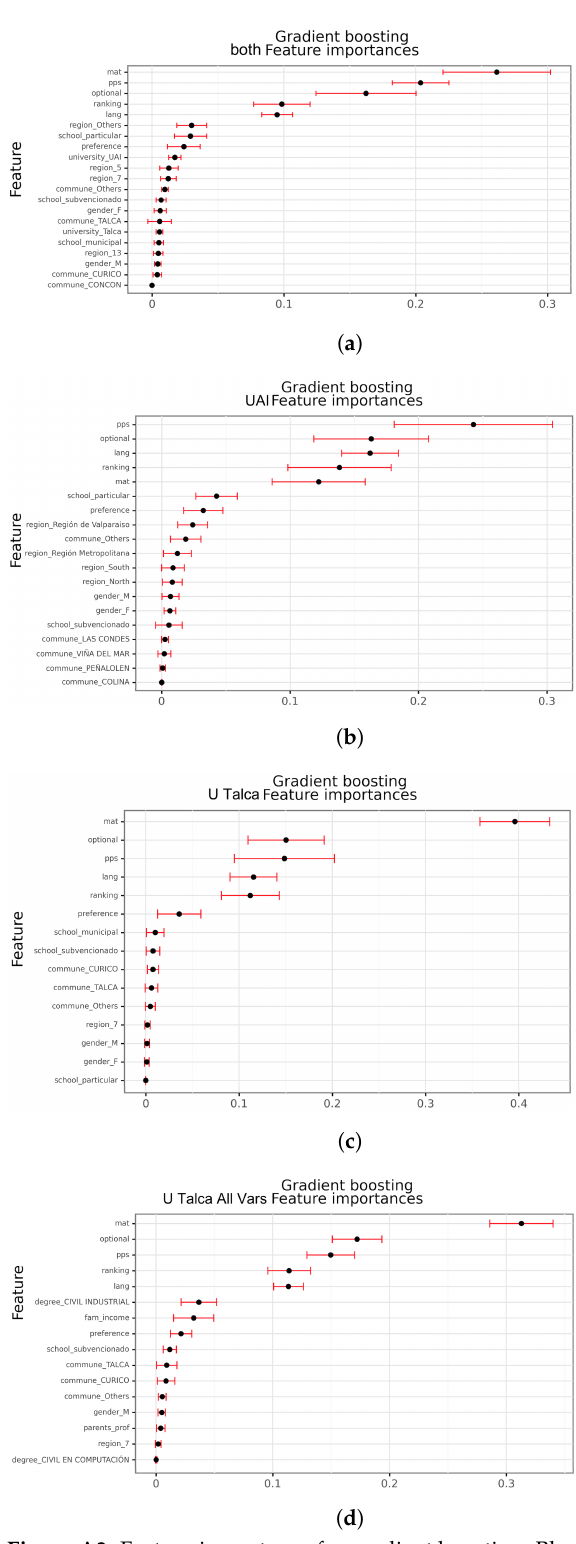
Figure A3. Feature importance for gradient boosting. Black dots correspond to the means, while red bars represent one standard deviation. ( a ) Both. ( b ) UAI. ( c ) U Talca. ( d ) U Talca All